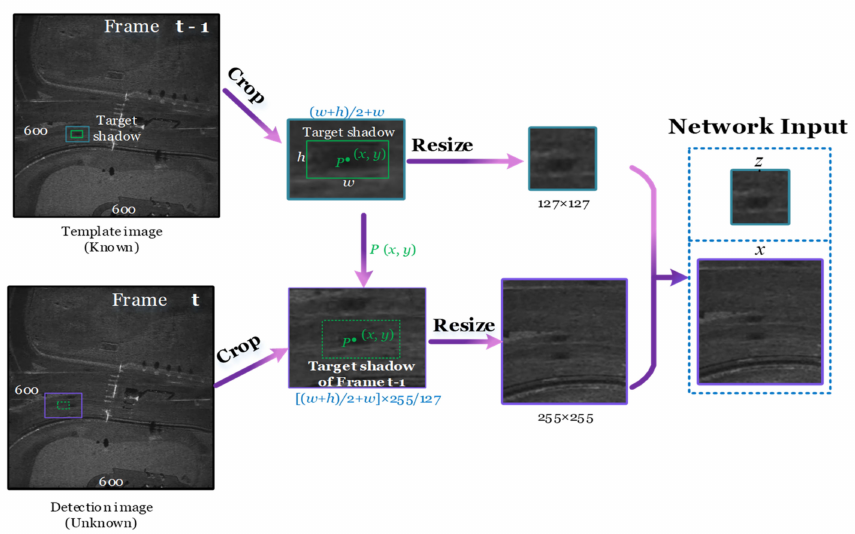
Figure 4. The input preprocessing of